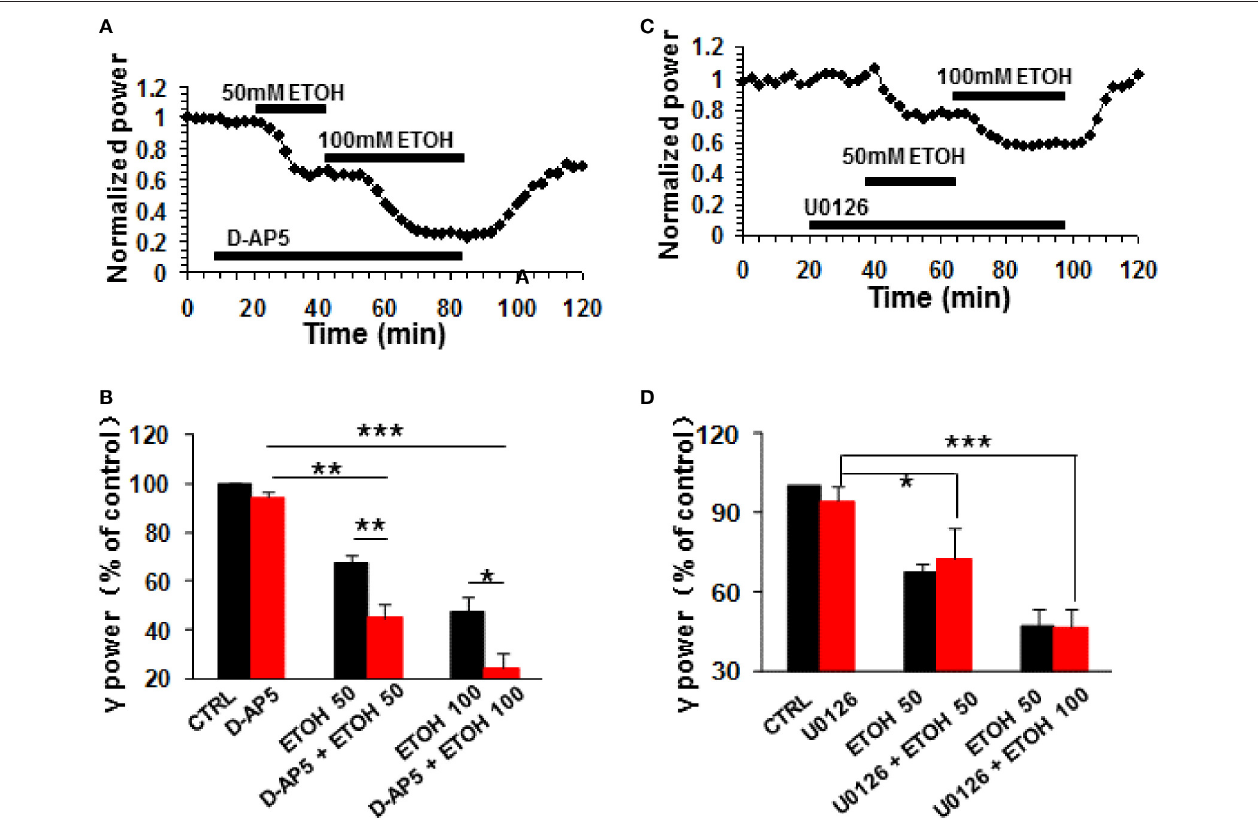
FIGURE 6 | The NMDA receptor antagonist and ERK inhibitor on ethanol-induced suppression of γ oscillations. (A) Example of the effect of ethanol on γ power in the presence of D-AP5 (10 µ M). Details as in Figure 2A . (B) γ power as % of baseline for NMDAR antagonist D-AP5, 50 and 100mM ethanol ( n = 8). Details as in Figure 2B . * P < 0.05; ** P < 0.01; *** P < 0.001. (C) Example of the effect of ethanol on γ power in the presence of ERK inhibitor U0126 (2.5 µ M). Details as in Figure 2A . (D) γ power as % of baseline for U0126, 50 and 100mM ethanol ( n = 8). Details as in Figure 2B . * P < 0.05; *** P <